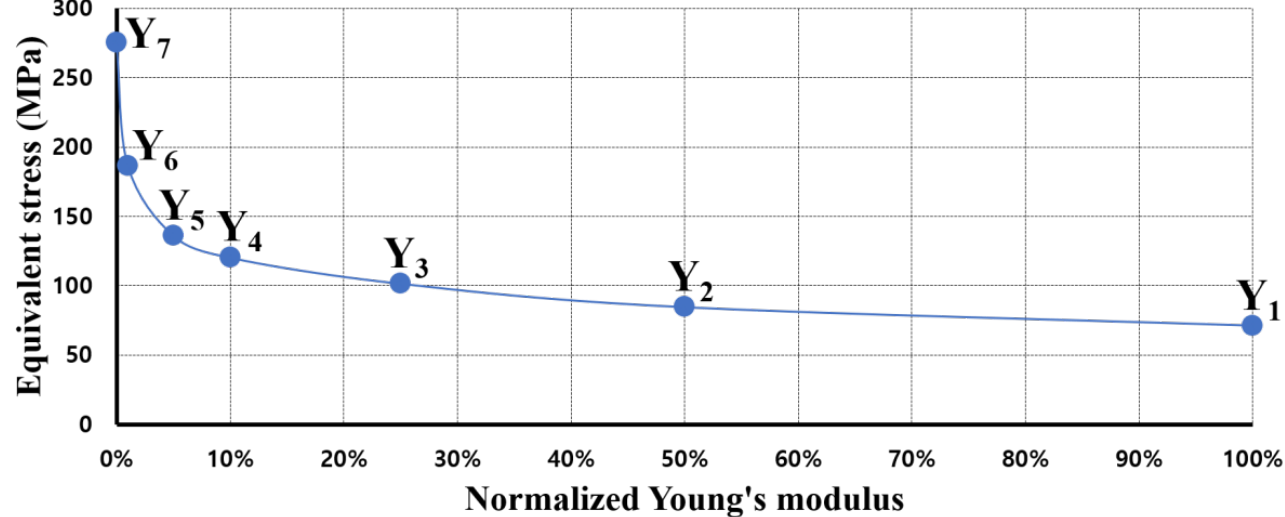
Figure 2. Equivalent stress of pedicle screw for spinal fixation when compared to Young’s modulus of vertebra. Table 2. Comparison of equivalent stress results of screws; flexion motion analysis in the fractured state.